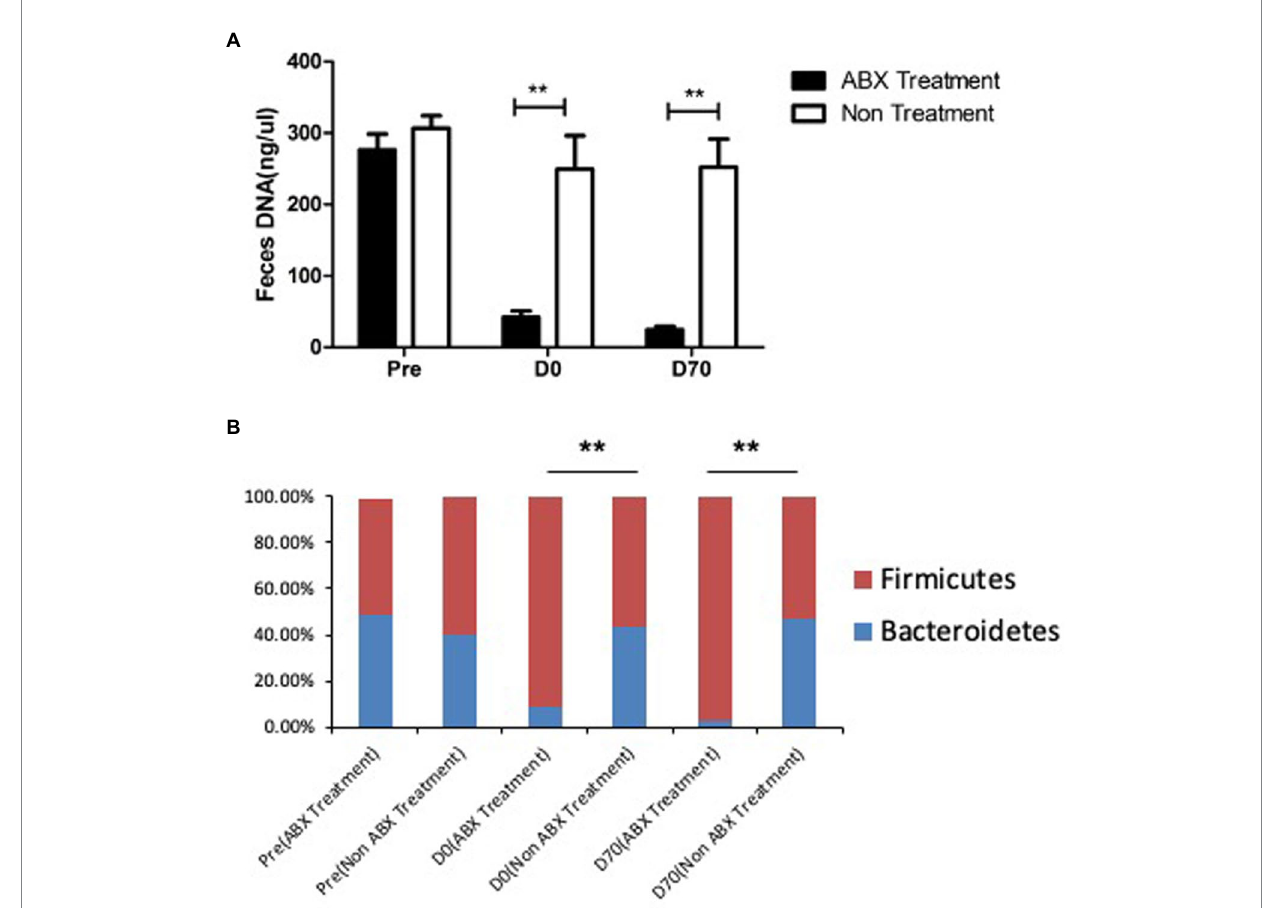
FIGURE 7 The fecal microbiota were changed sigificantly by oral antibiotics treatment. Female DBA2/J mice were treated without (Non, n = 20) or with (ABX, n = 20) oral antibiotics for 21 days as described in Figure 1 legend. Fecal samples were taken from mice prior to the oral antibiotics treatment (Pre), 21 days after the treatment but before chlamydial infection (D0) and 70 days after chlamydial infection (D70) for extracting DNA (panel A ) and detecting the relative abundance of 16S rRNA gene from bacterial phyla bacteroidetes (blue, panel B ) and firmicutes (red, panel B ) using qPCR. Please note that both fecal DNA amount and relative abundance of bacteroidetes and firmicutes in the fecal samples were significantly different between mice with or without the oral antibiotics treatment for 21 days (** p < 0.01,